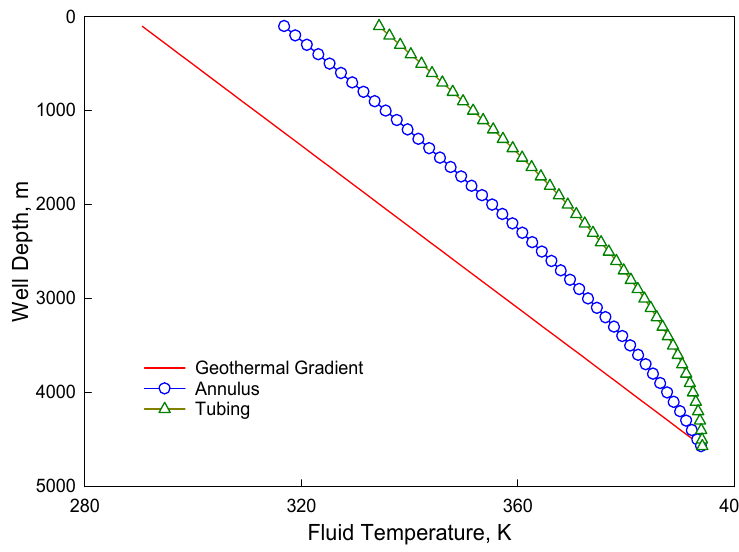
Figure 2. Baseline for sensitivity analysis.